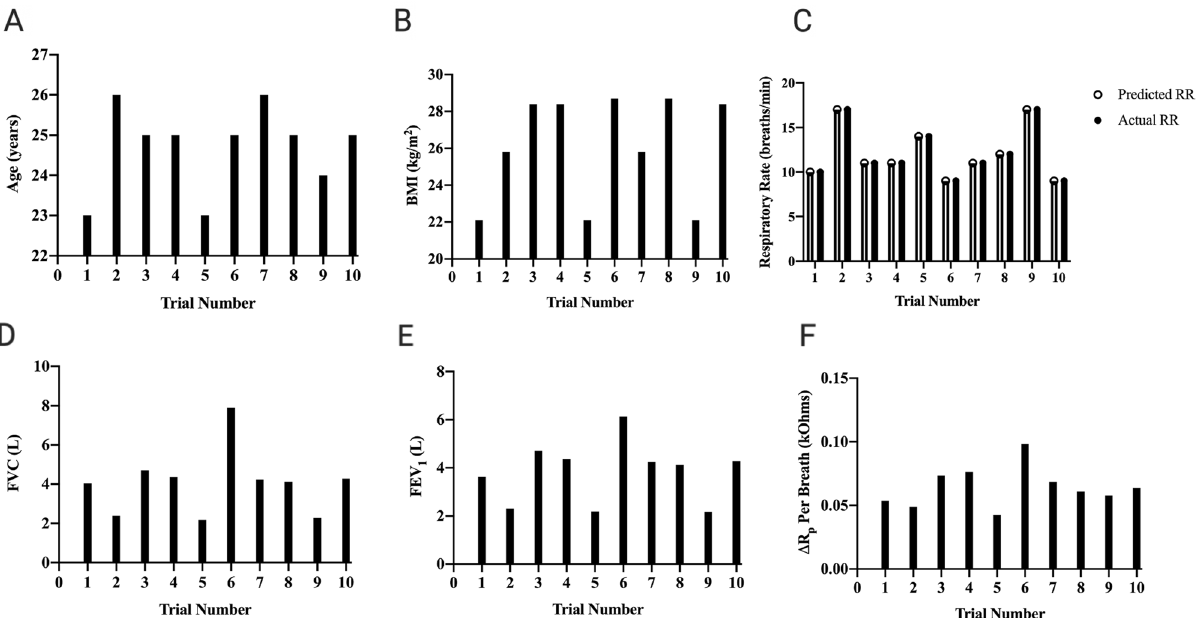
Figure 4. Participant variables and demographics. ( A ) Age of participants by trial. ( B ) Body mass index (BMI) of participants by trial. ( C ) Respiratory rate of participants by trial. ( D ) Forced vital capacity (FVC) of participants by trial. ( E ) Forced expiratory volume in one second (FEV 1 ) of participants by trial. ( F ) Change in R p of participants by trial.